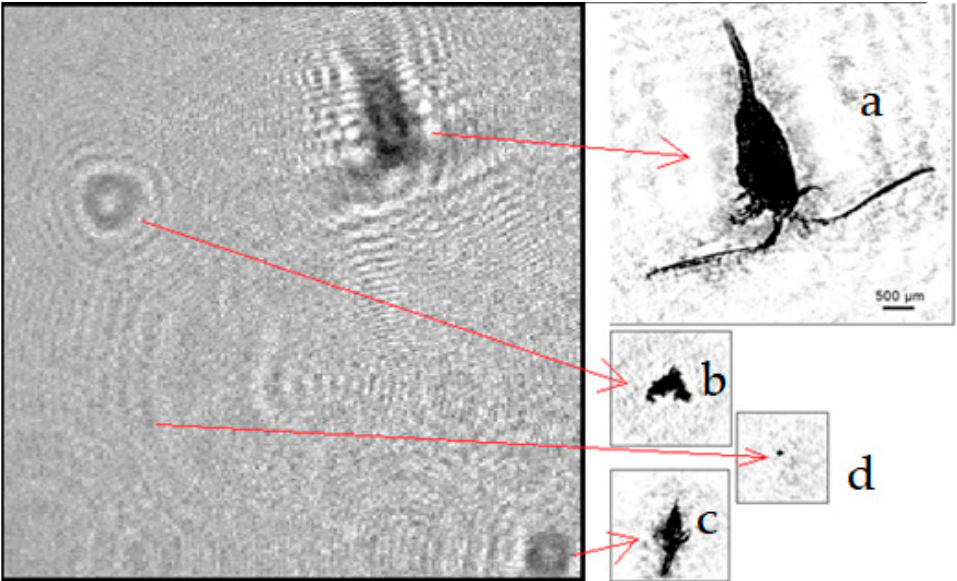
Figure 4. Digital hologram recorded in Lake Baikal and images of particles reconstructed from it: a—epischura, c—epischura nauplius, b and d—suspension particles.